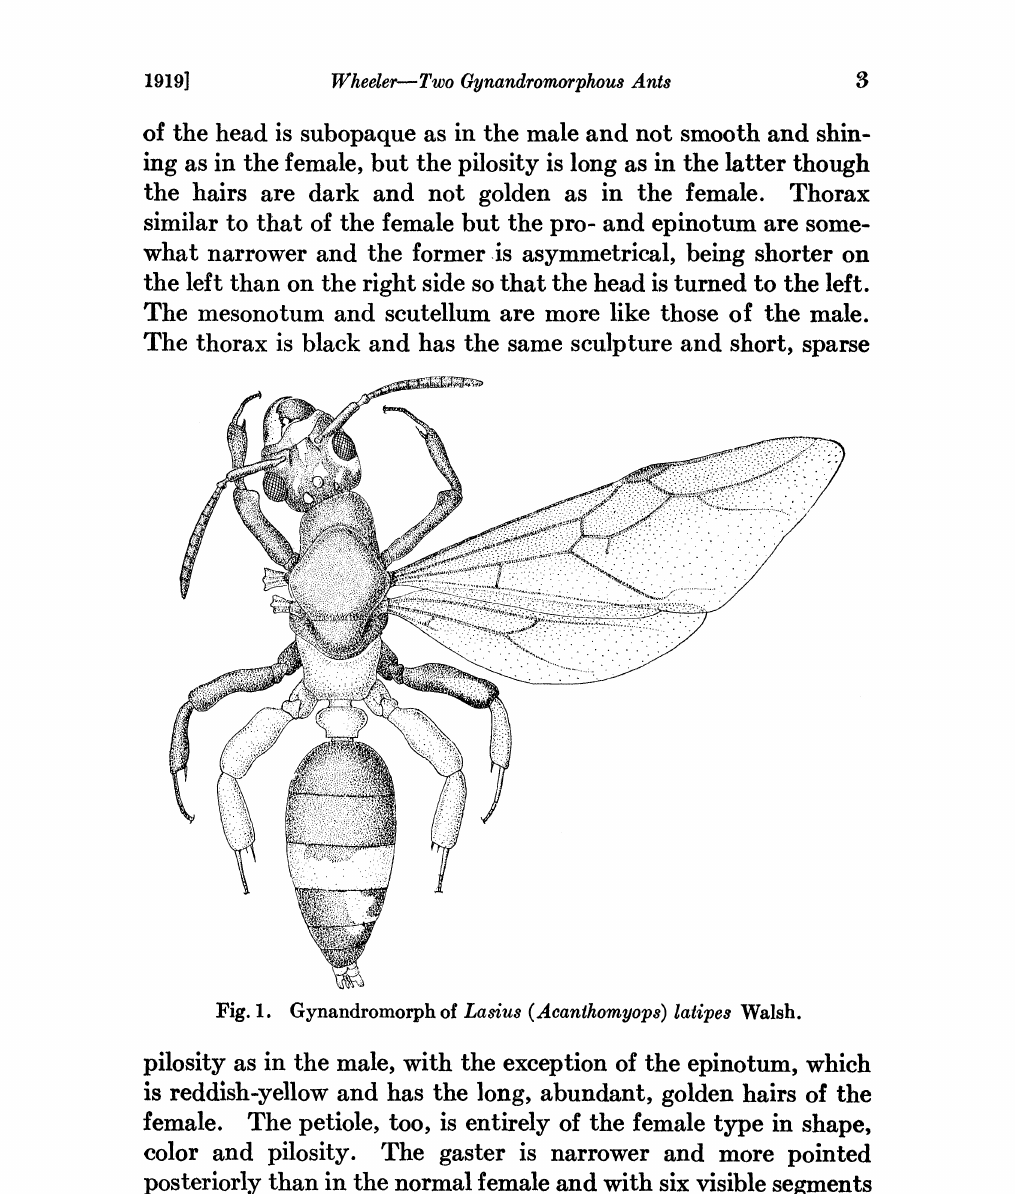
Fig. 1. Gynandromorph of Lasius (Acanlhomyops) latipes